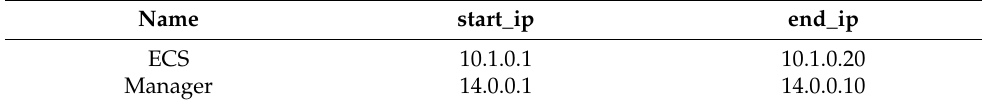
Table 6. Device Address Registry